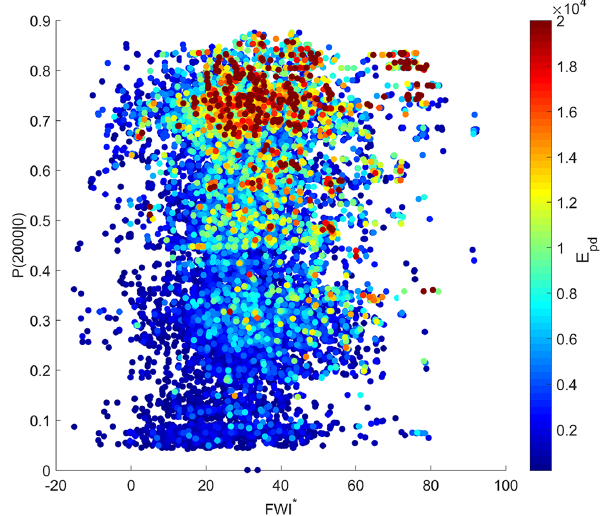
Figure 10. Daily energy per pixel released by fires as a function of FWI ∗ and P( 2000 | 0 ) . Circles are coloured according to the released energy (GJ).